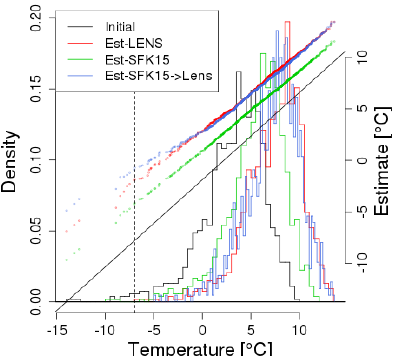
Figure 11. Comparisons between reanalysis data from the winter months (DJF) in Seattle in the period 1979–2016 projected with three different methods. (1) Using the 40-member LENS ensem- ble to construct a quantile map (shown in red), (2) using the 50 simulations from SFK15 (in green), and (3) using method (2) and then re-calibrating the quantile map using one LENS simulation (in blue). For all three models, every year is projected into year 2099 and compared using qq-plots juxtaposed by histograms. We project into a single year here instead of projecting each year by a constant time shift to show the flexibility of the method. The fact that the re-calibrated method (in blue) is close to the LENS model shows that even one high-resolution simulation can get close to the re- sults based on all 40 LENS simulations when aided by a set of low- resolution simulations (SKF15). The dashed vertical line in each plot represent the . 01 quantile for the initial